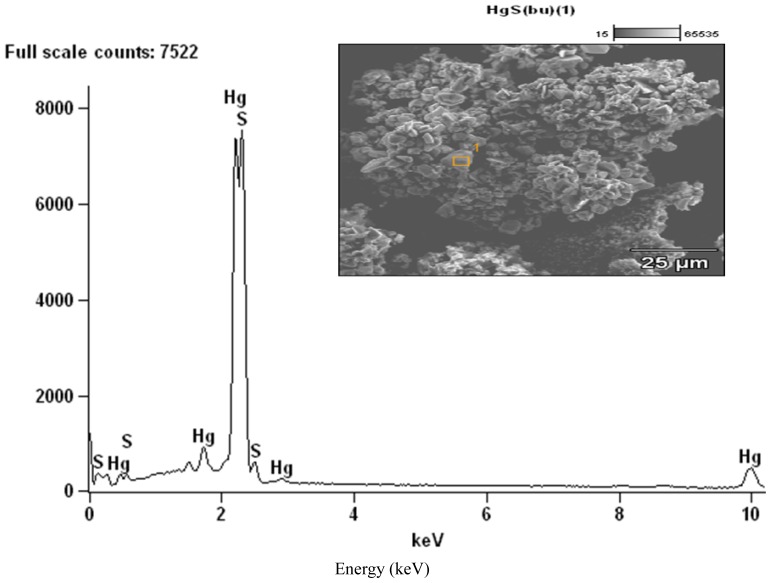
EDX of the decomposed products from complex HgL22 at 350 °C.